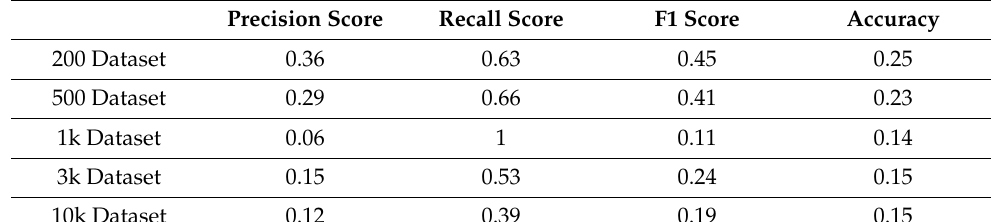
Table 6. Results of K-means.